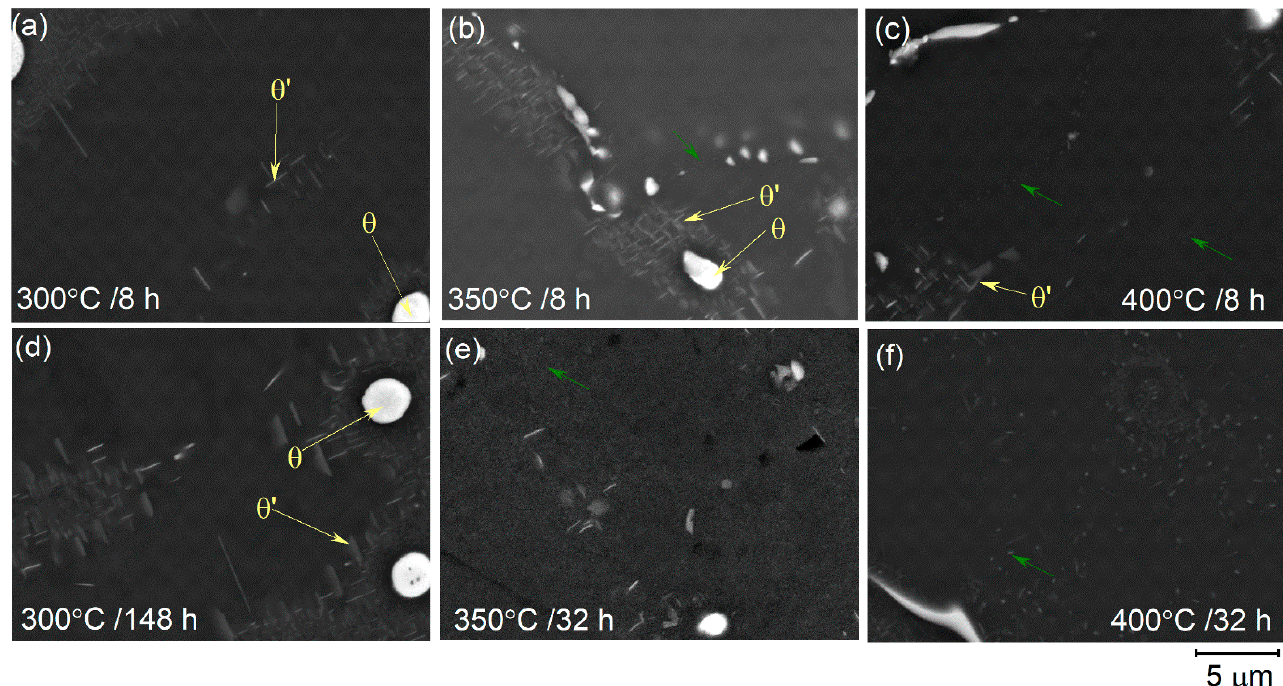
Figure 4. SEM-BSE micrographs for the Al-2%Cu-2%Mn alloy aged at ( a , d ) 300 °C ( b , e ) 350 °C ( c , f ) 400 °C.